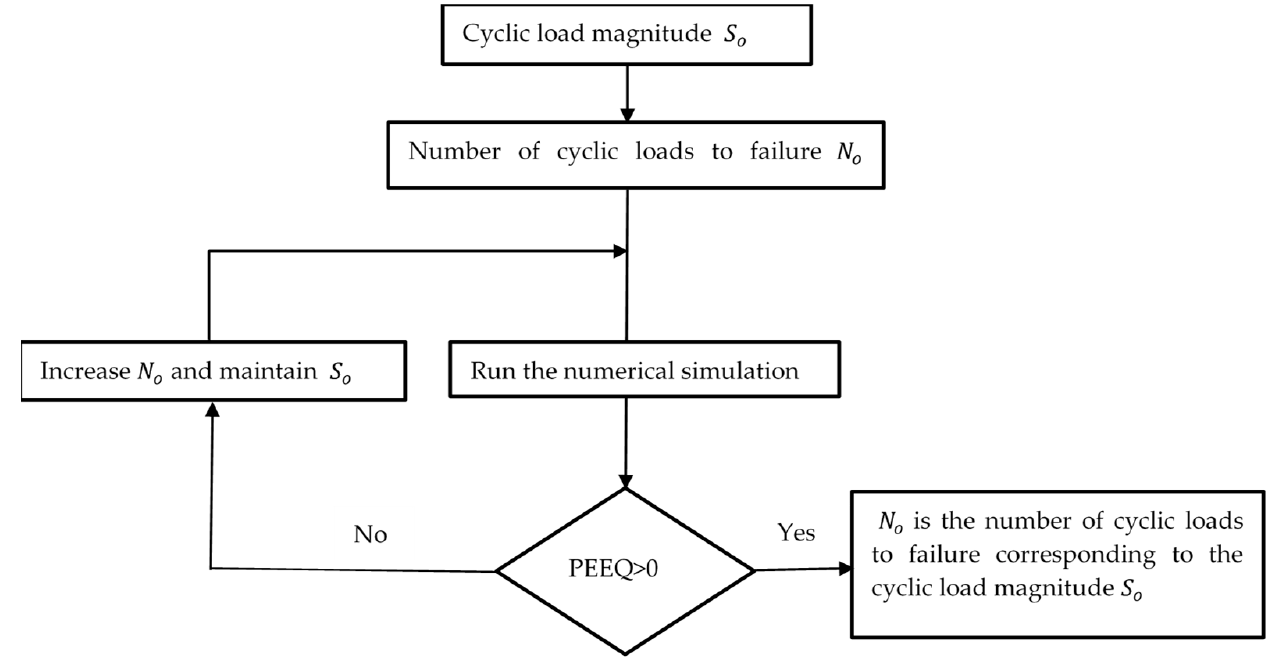
Figure 5. Detailed algorithm of the establishment of the S ‐ N curve.